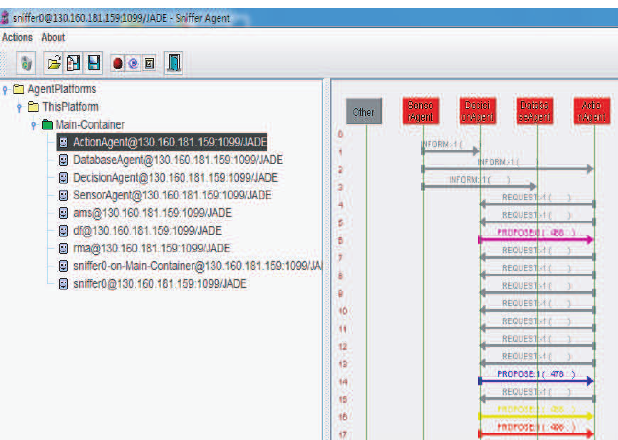
Figure 10. Snapshot of the JADE development